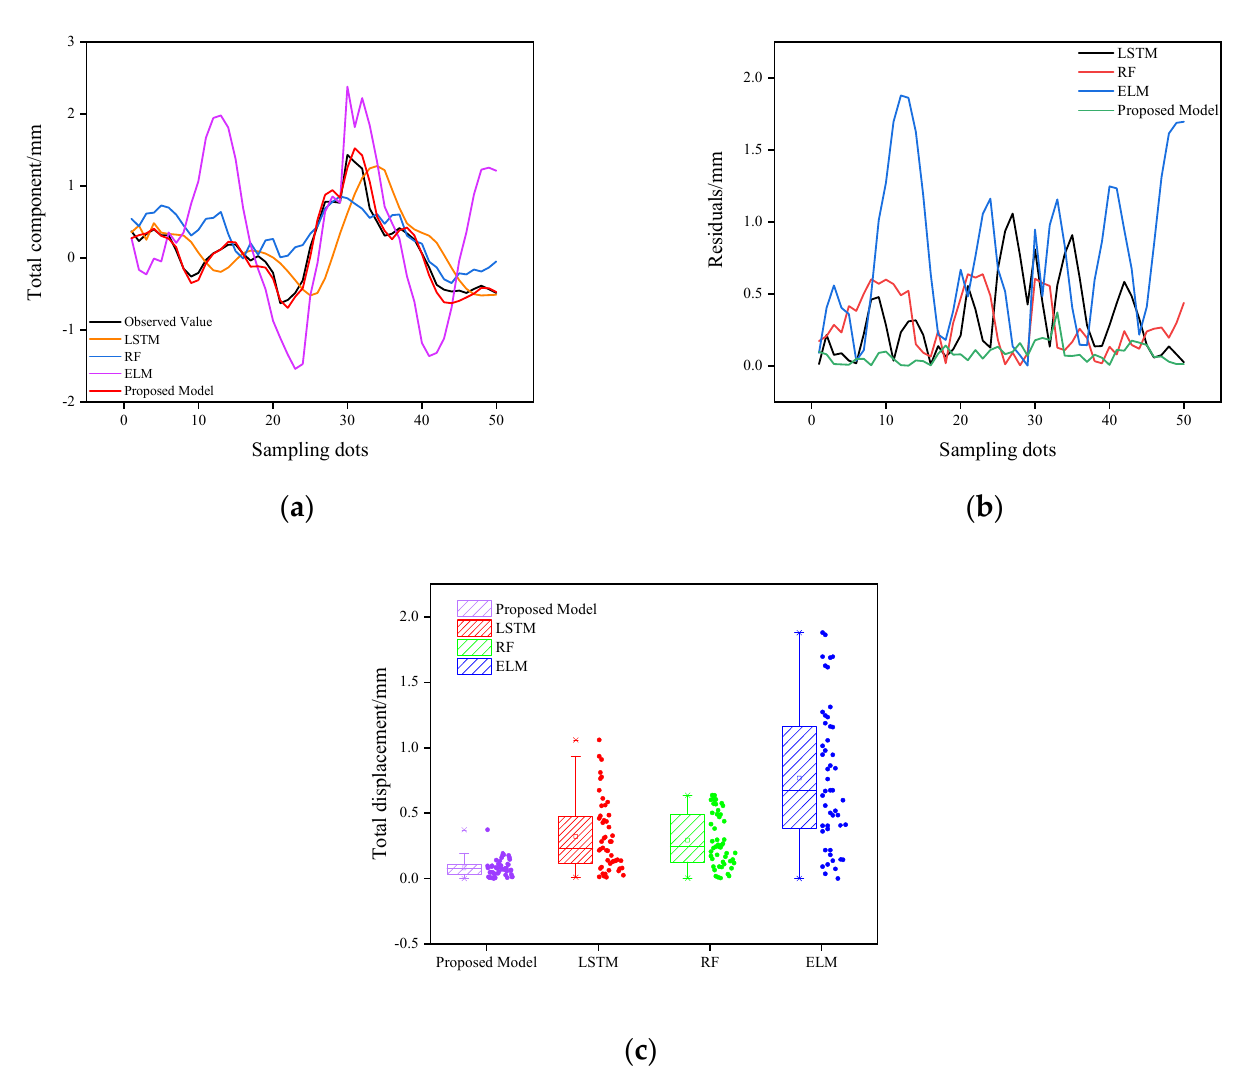
Figure 12. Comparison of total prediction results of measuring point EX2. (( a ) prediction results; ( b ) prediction residuals; ( c ) boxplot of residuals). Table 6. Comparison of evaluation indexes of measuring point EX2.